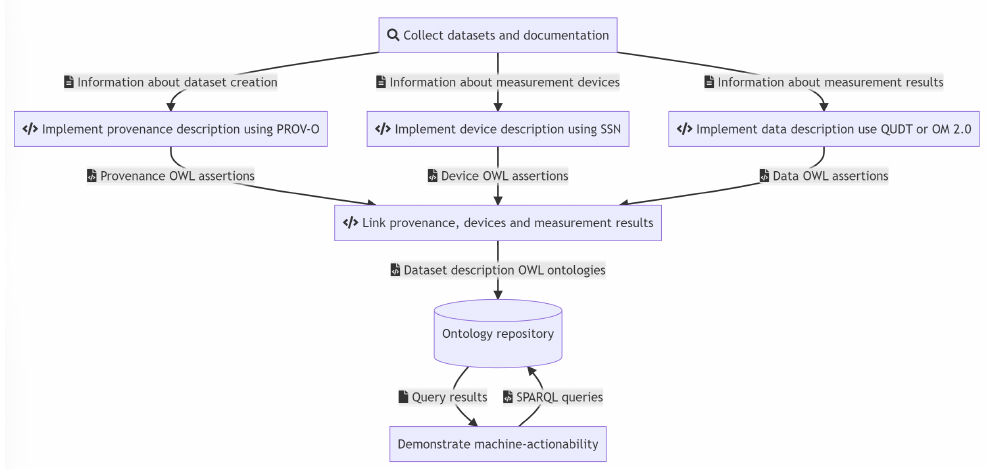
Figure 4. Implementation